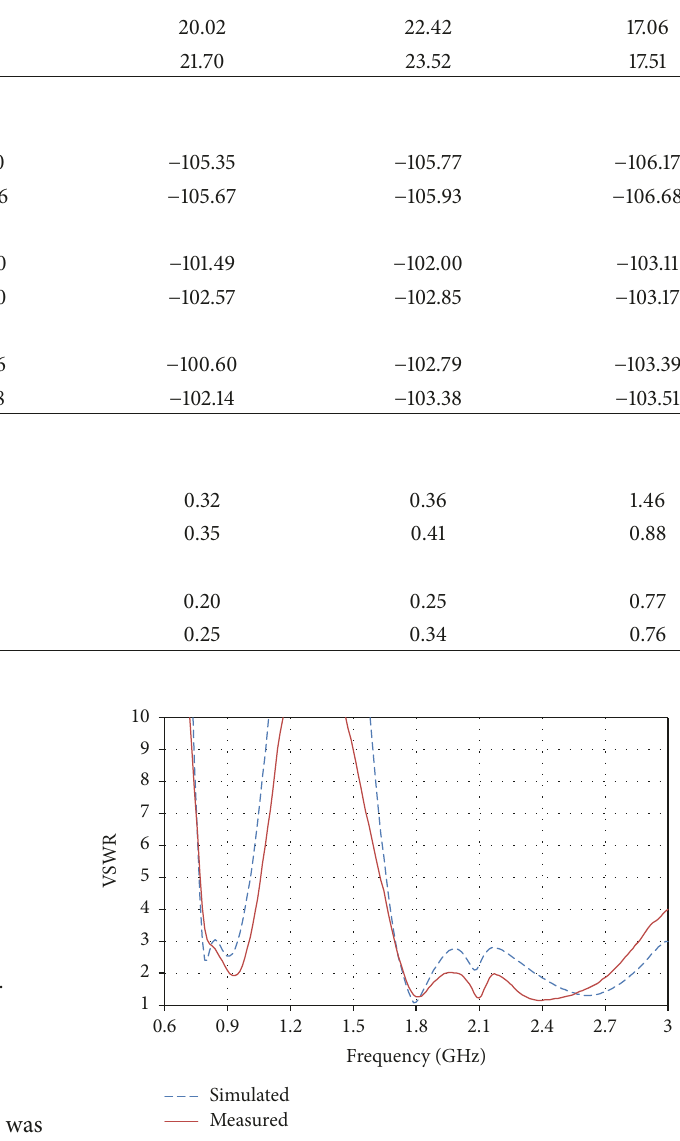
Figure 6: Simulated and measured VSWR of the proposed antenna.